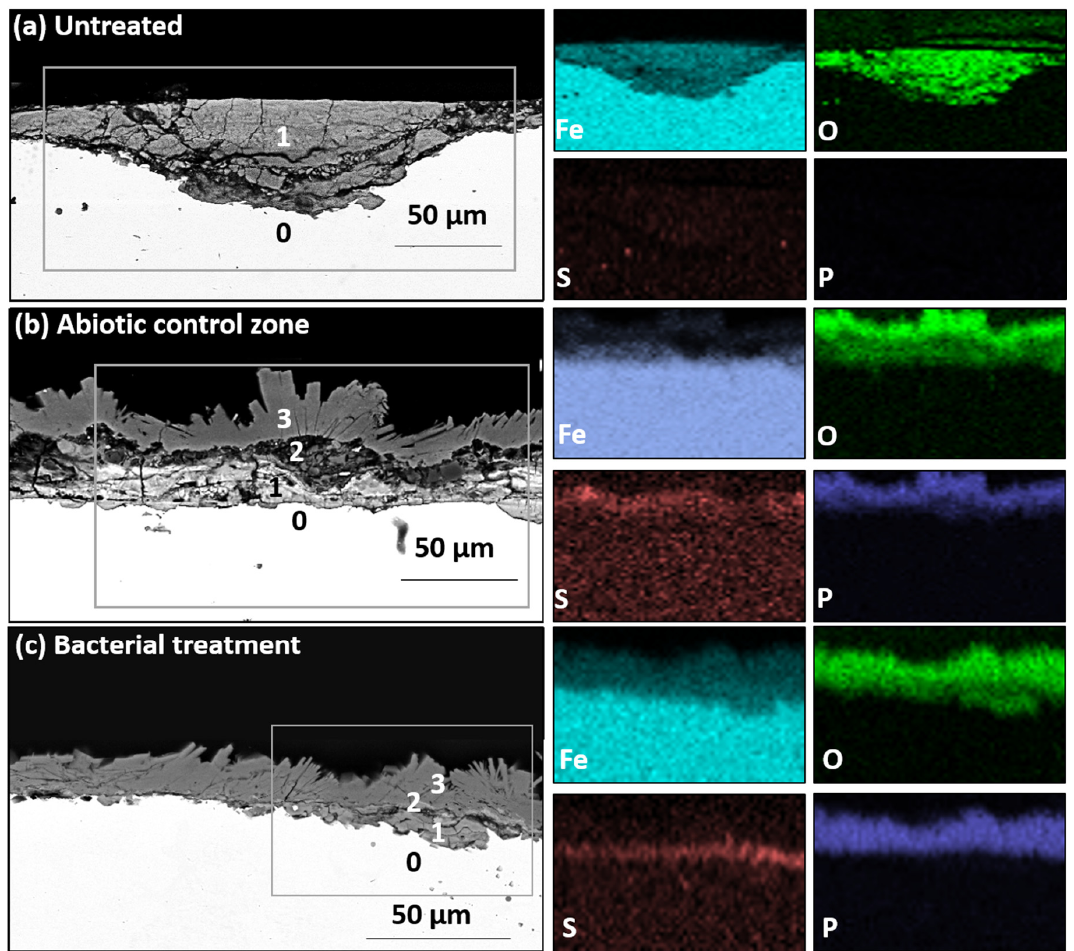
Figure 4. SEM–EDS characterization of ( a ) untreated, ( b ) abiotic control and ( c ) bacterially treated iron coupons. On the left, images of backscattered electrons with a square box indicating the analyzed area and numbers indicating the di ff erent layers present: 0 = bulk metal; 1 = original corrosion layer; 2 = newly formed S-rich layer; 3 = biogenic layer. On the right, elemental mapping showing the presence of iron, oxygen, sulfur, and phosphorus in the di ff erent layers.